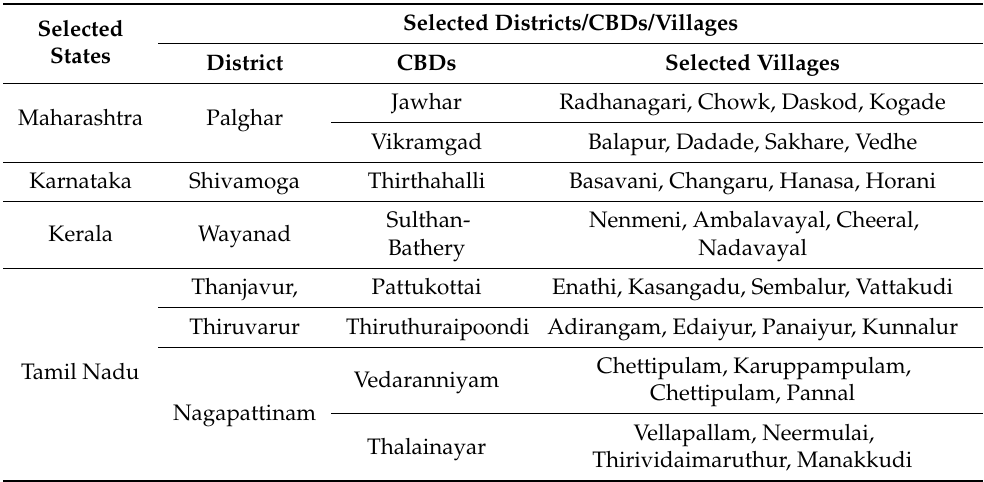
Table 1. Selection of study areas–districts/CBDs/villages in the Western-Ghats Region and East- Coastal Region of India. Selected Districts/CBDs/Villages Selected States District CBDs Selected